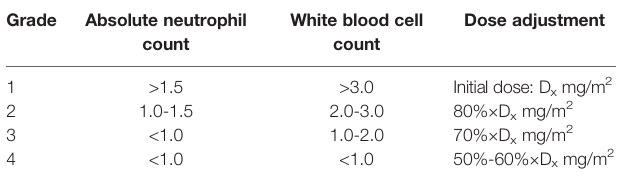
TABLE 2 | Chemotherapy dose